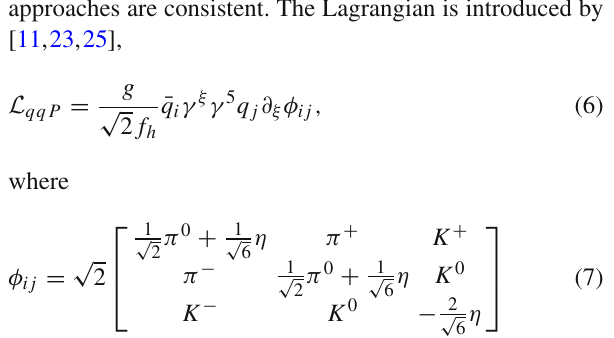
Fig. 2 Feynman diagram for D ∗ energy